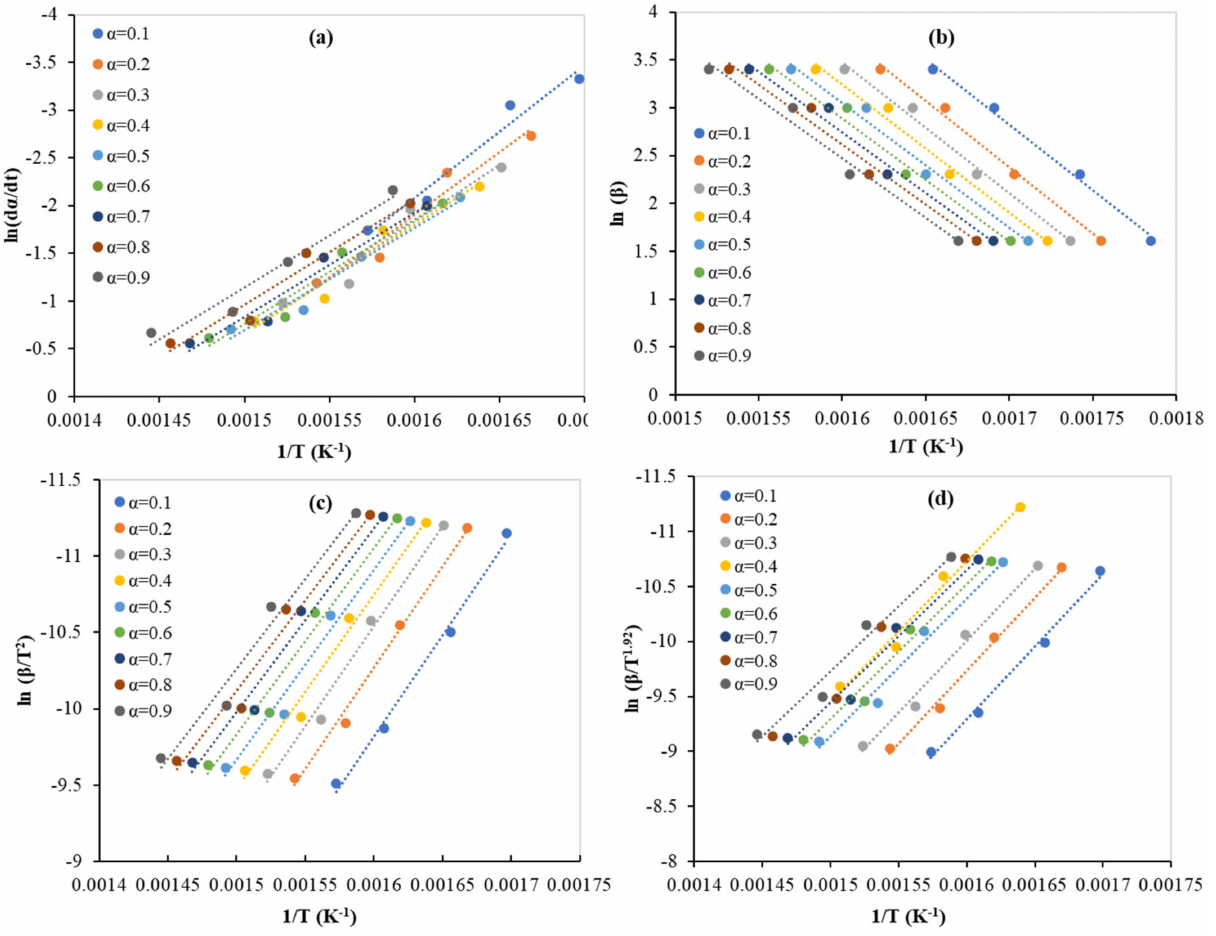
Figure 2. Regression lines of the experimental data of the PLA pyrolysis by: ( a ) Friedman, ( b ) FWO, ( c ) KAS, and ( d ) Starink models.